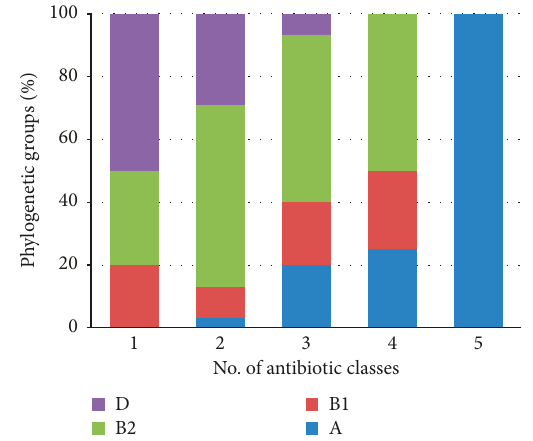
Figure 5: Distribution of the phylogenetic groups based on the number of antibiotic resistance patterns in E. coli .